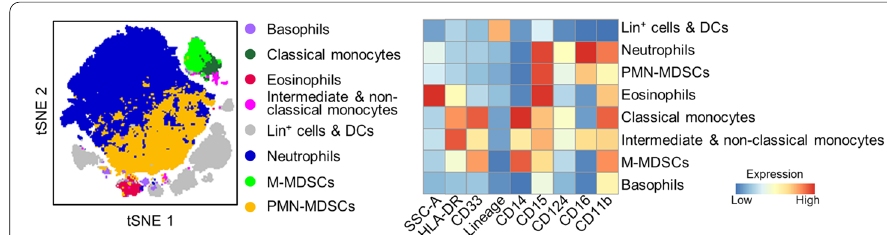
Fig. 1 Identification of MDSCs by flow cytometry and unsupervised clustering. Blood was collected in tubes containing lyophilized fluorescently labeled antibodies targeting MDCSs and analyzed as described in “Methods”. t‑SNE plots of leukocyte populations (left) and relative side scatter area (SSC‑A) and expression levels of surface markers (right). Lin : lineage (i.e., CD3, CD19 or CD56) positive; DCs: dendritic cells +